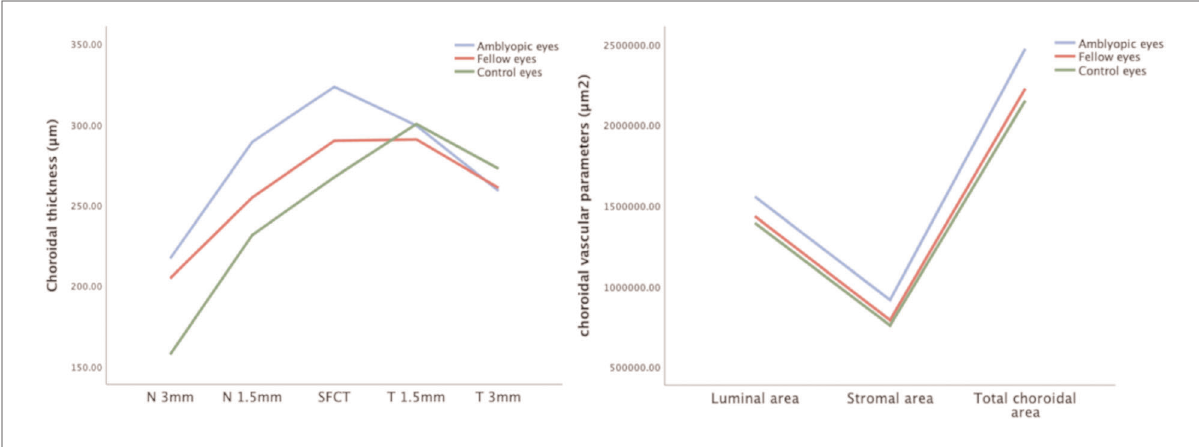
FIGURE 5 Choroidal thickness and vascular parameters among the three groups. The subfoveal choroidal thickness, temporal and nasal choroidal thickness, LA, SA, and TCA values of amblyopic eyes, fellow eyes, and